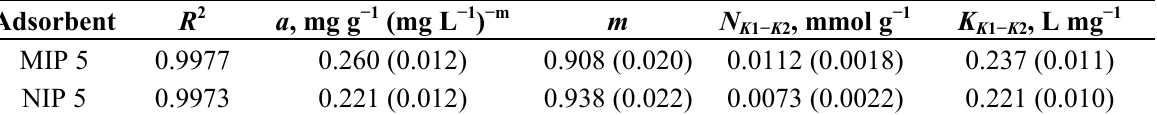
Table 3. Parameters for fitting to Freundlich isotherm model and calculated binding parameters.